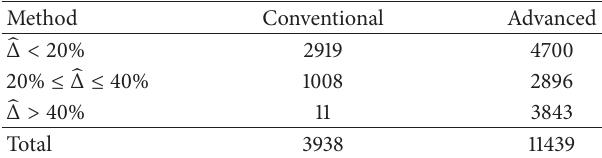
Table 1: Number of feasible switching index systems 𝐽 (𝑑) for conventional and advanced designs with 𝑀 = 8 switching